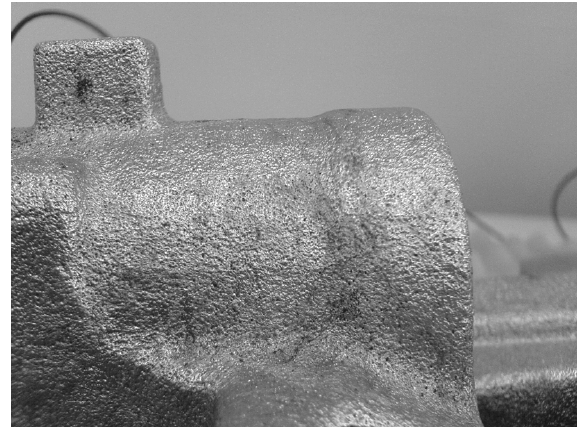
Fig. 3. Illustration of the surface porosity of the caliper produced in the RP